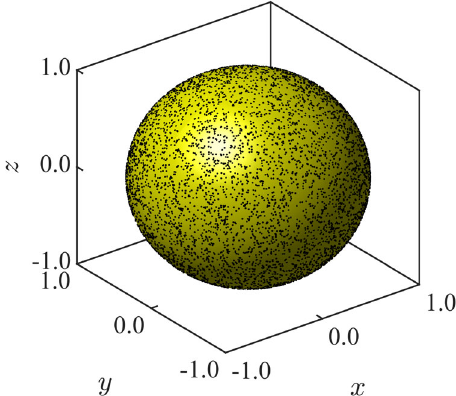
Fig. 7 Monte Carlo sampling in the phase space. Typical Monte Carlo sampling of 10 4 spin angles ( θ , ϕ ) in the phase space, showing a uniform coverage of the unit sphere by the sampled spin angles